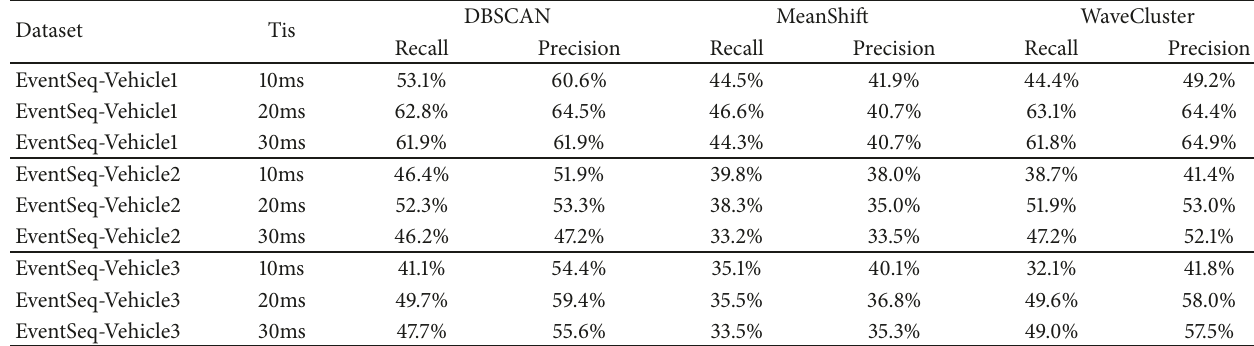
Figure 5: Detection-by-clustering results of (a) DBSCAN clustering applied to the events data accumulated at 20ms time interval. (b) MeanShift clustering applied to the events data accumulated at 20ms time interval. (c) WaveCluster clustering applied to the events data accumulated at 20ms time interval (best viewed in color). Table 3: The performance of clustering